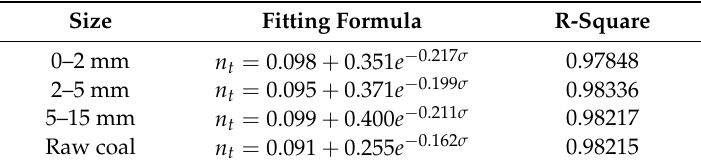
Table 4. Fitting formulae of total porosity for each particle size class.